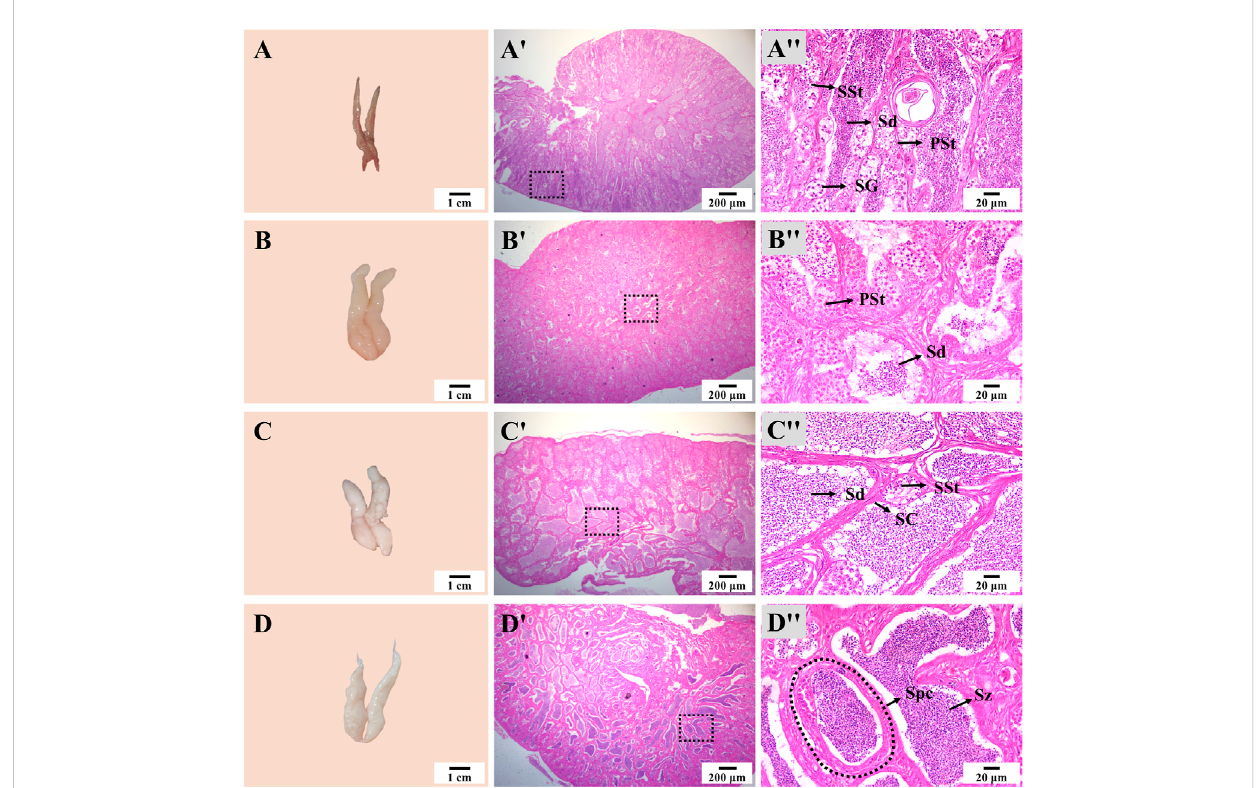
FIGURE 7 Testisappearanceandhistologyduringthermo-photoperiodmanipulationoflargemouthbass. (A – D) TestisappearanceatStage1,Stage2,Stage3, andStage4,respectively,showingremarkablechangesintestismorphology. (A ʹ – D ʹ ) CorrespondingtestishistologyatStage1,Stage2,Stage3,andStage 4,respectively,showingthedramaticchangesinsizeandcompositionofspermatocytes. (A ʺ -D ʺ ) Enlargementofthedottedboxinthehistological image of (A ʹ – D ʹ ) , respectively. Stage 1 , before the initiation of ovarian redevelopment, before temperature decrease, 16 August. Stage 2 , supposed maturation of ovary, right after temperature increase, 25 September. Stage 3 , supposed spawning period, 5 weeks after the maintenance of spawning temperature, 31 October. Stage 4 , spawning was observed in all groups except the NTNP group, 21 November. SG, spermatogonia. PSt, primary spermatocyte. SSt, secondary spermatocyte. Sd, spermatid. Sz, spermatozoa. Spc, spermatocyst. SC, Sertoli